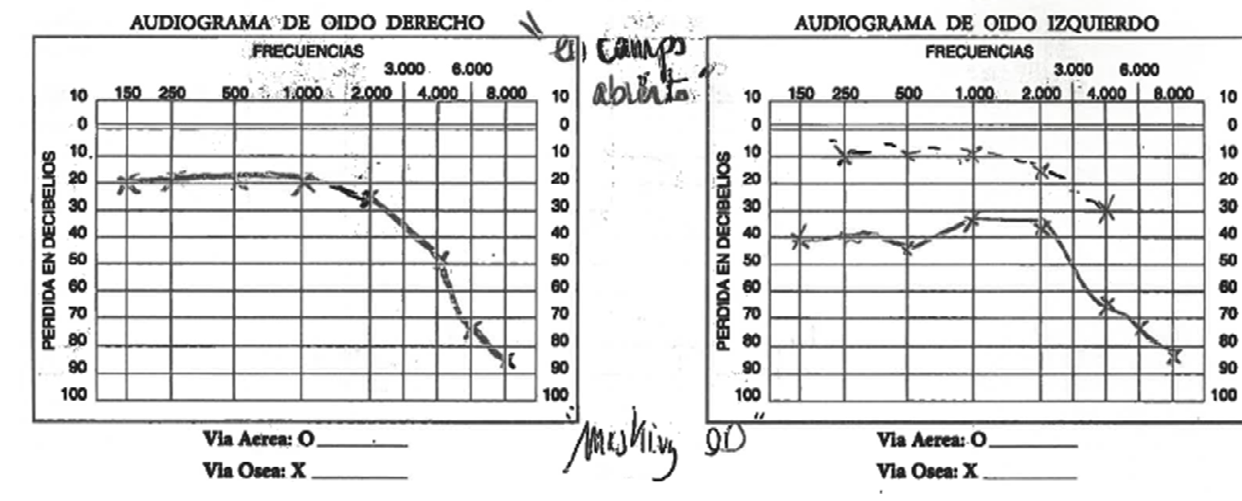
Figure 4. Audiogram of